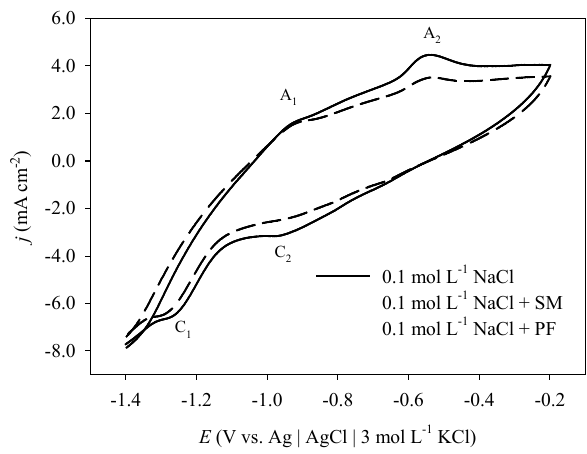
Figure 2: Cyclic voltammograms for Fe electrode in 0.1 mol L -1 NaCl containing extract (SM) and phenolic fraction (PF) of Satureja montana L. n = 40 mV s −1 .